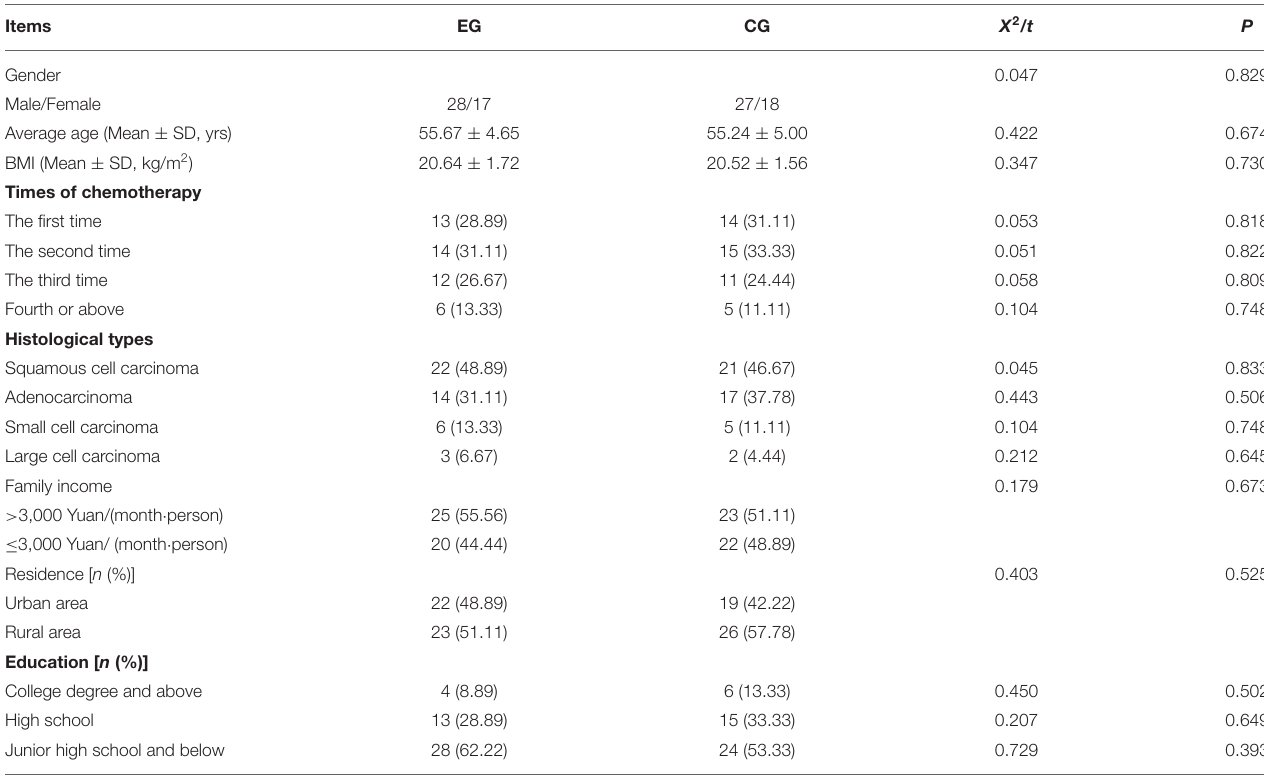
TABLE 1 | Comparison of clinical data.